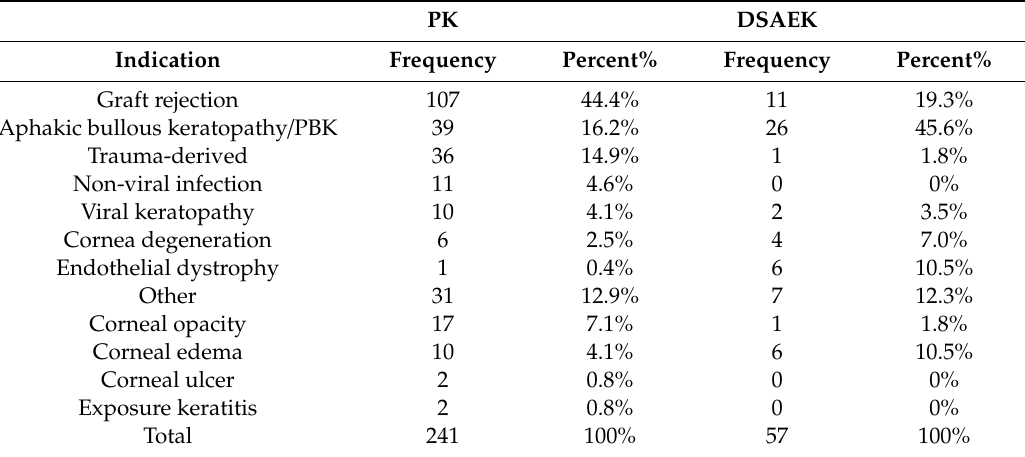
Table 3. Indications of PK and DSAEK.